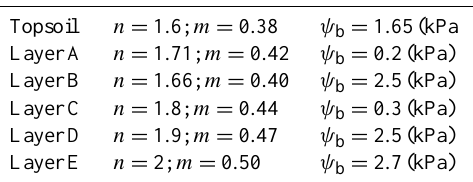
Table 4. Parameters of van Genuchten and Nielsen model. The val- ues of the bubbling pressure, or air-entry tension, ψ b , were de- termined through the graphic method proposed by Fredlund and Xing (1994).